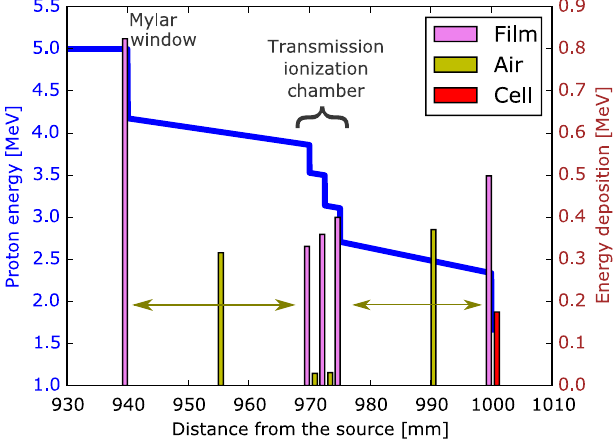
FIG. 7. Graph depicting the energy decrease (blue curve, vertical scale on the left) of an instance proton with a 5 MeV initial energy, as it propagates along the beam line. The energy deposited in the various absorbing elements encountered on its path is represented by the bar plot (vertical scale on the right). Each bar is centered in its energy deposition longitudinal range to preserve proportionality between the energy deposition value and the area of the corresponding bar.